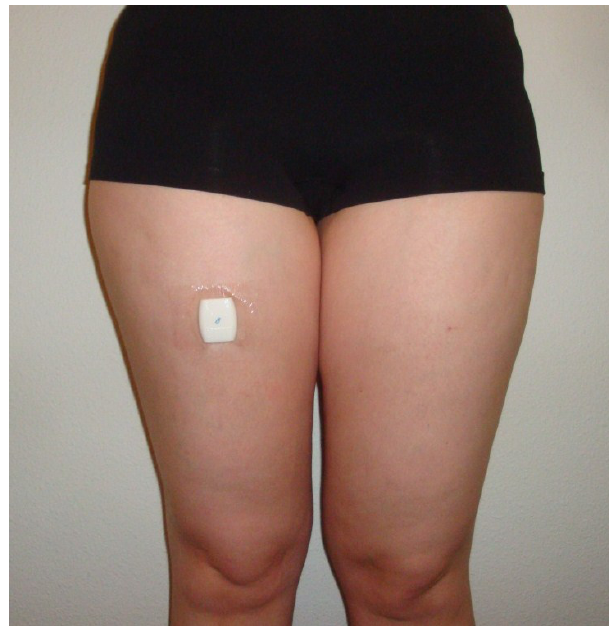
Figure 1. The Activ8 attached to the front of the less-affected thigh.